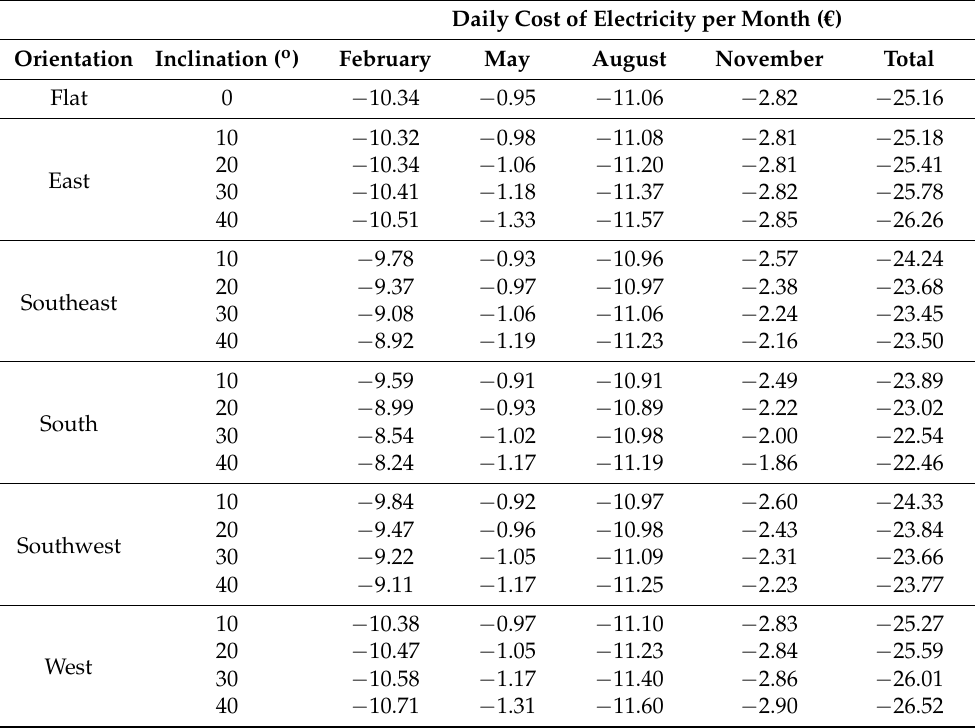
Table 2. Daily cost of electricity per month for medium-consumption households.